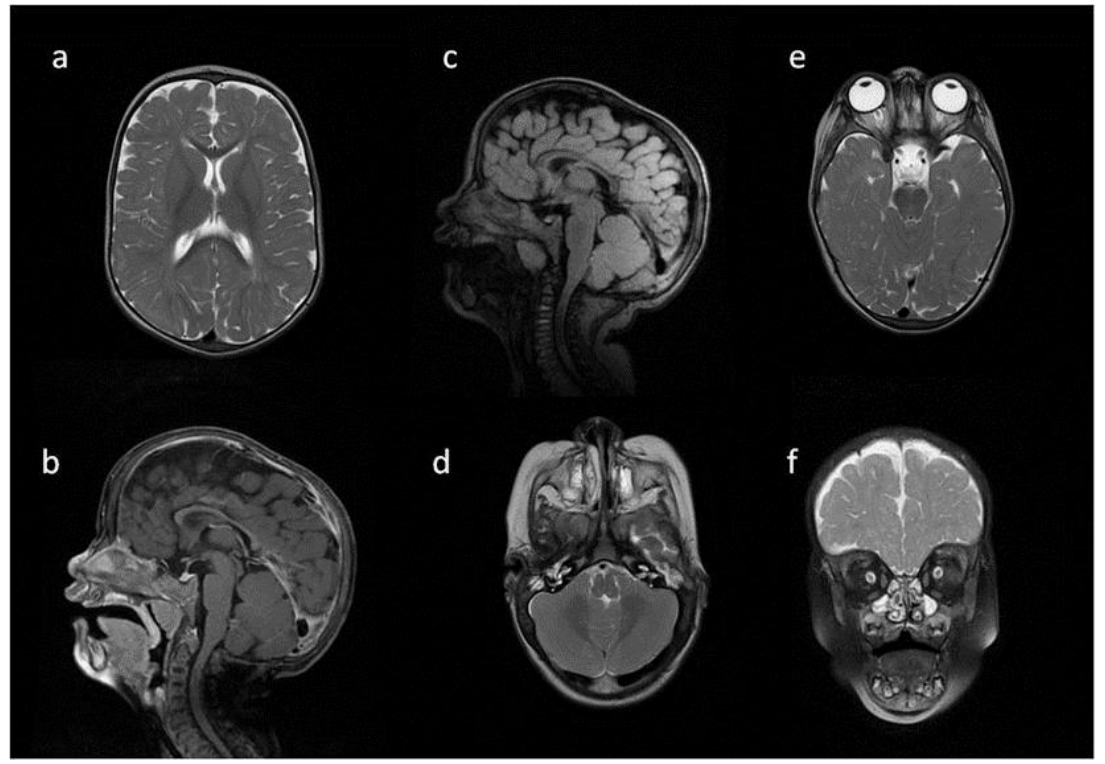
Figure 3. Brain MRI. Patient 3. ( a , e , d ) T2 axial; ( f ) T2 coronal; ( b , c ) T2 sagittal; ( b ) T1 contrast-enhanced; ( c ) T2 FLAIR. Findings: ( a ) delayed myelination; ( b , c ) J-shaped sella turcica, dysplastic dens; ( d ) temporal bone air cells effusion, posterior fossa horns; ( e , f ) enlarged optic nerve sheath.